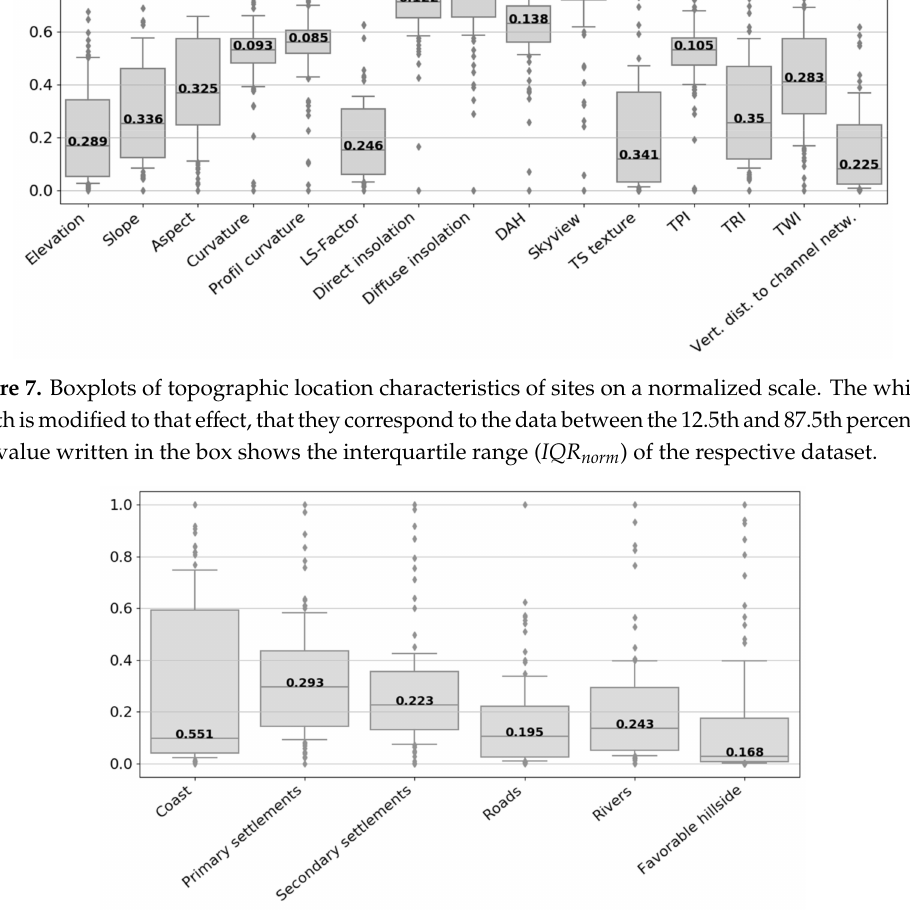
Figure 8. Boxplots of cost distance location characteristics of sites on a normalized scale. The whisker length is modified to that e ff ect, that they correspond to the data between the 12.5th and 87.5th percentiles. The value written in the box shows the IQR norm of the